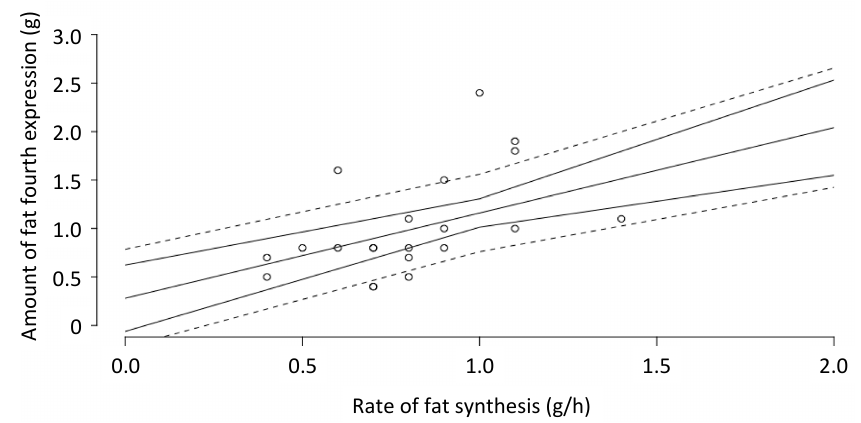
Figure 4. Relationship between the amount of fat from the fourth expression and the hourly rate of milk fat synthesis calculated from the 24-h milk profile data ( p = 0.054). Fitted model (solid line), with the confidence (solid line) and prediction interval (dashed line). n = 29 breasts.